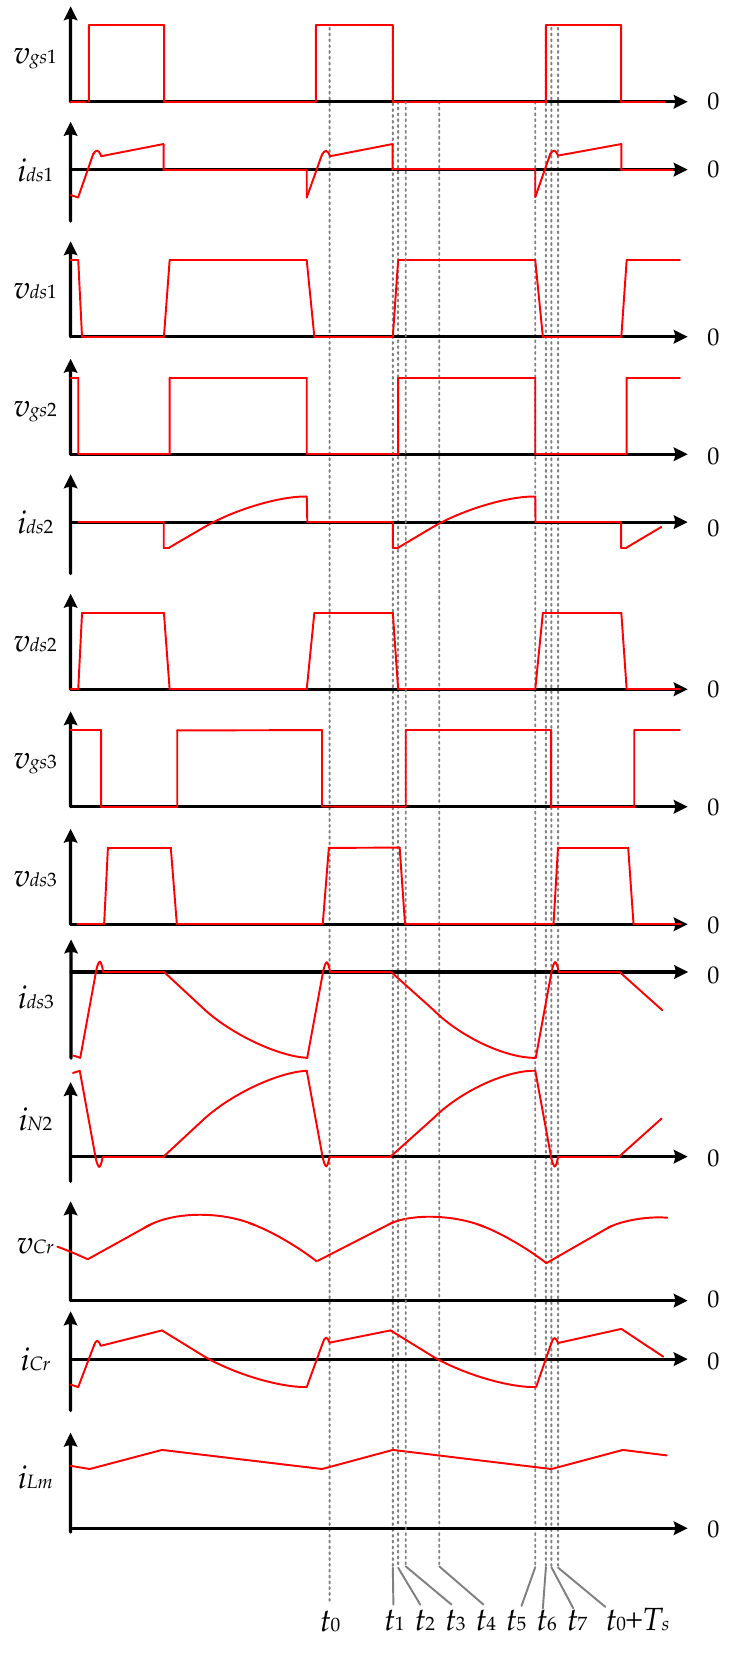
Figure 3. Operation waveforms of the proposed